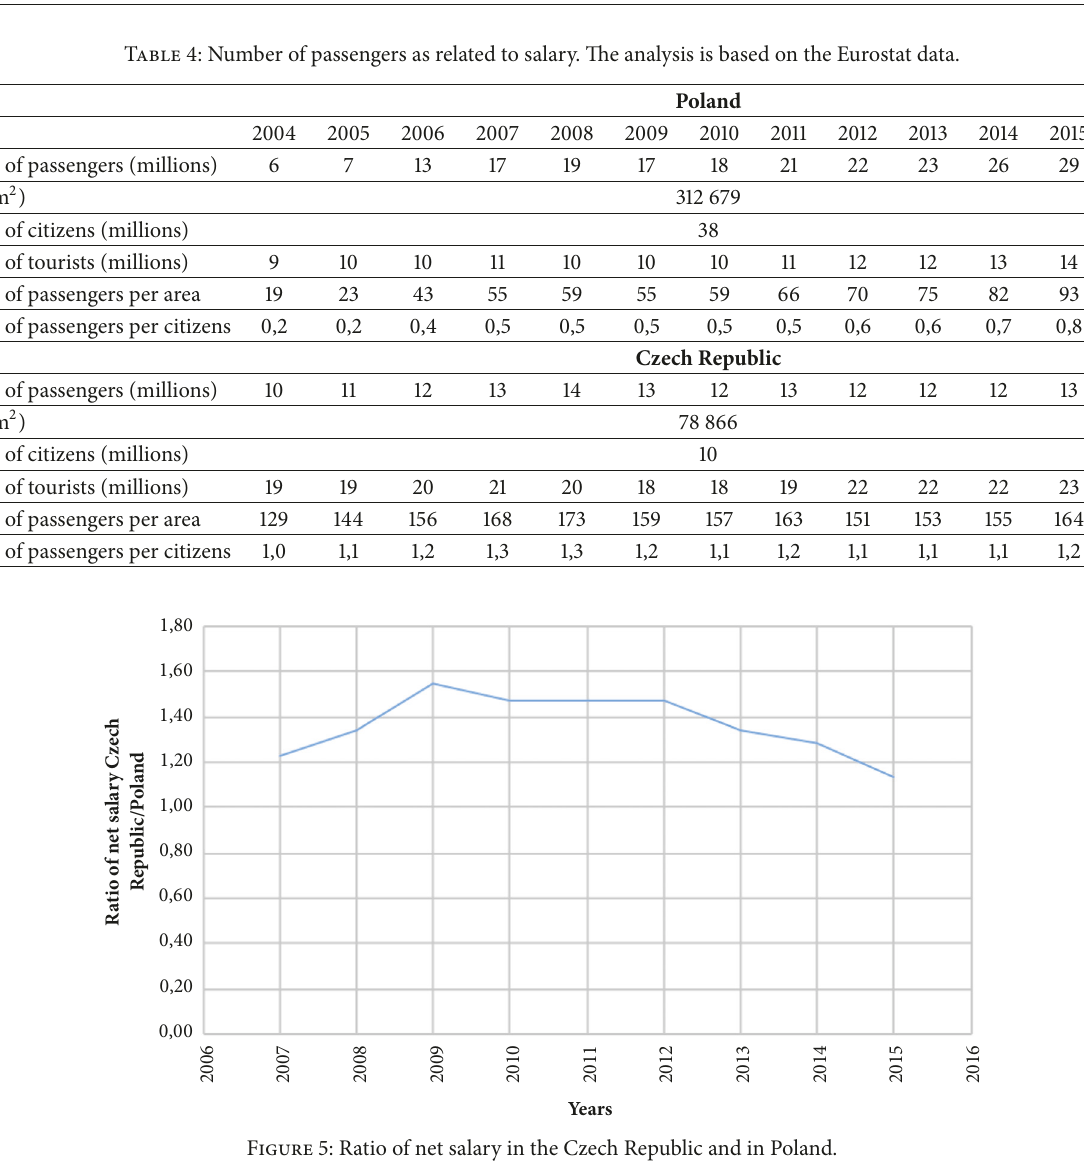
Table 4: Number of passengers as related to salary. The analysis is based on the Eurostat data.